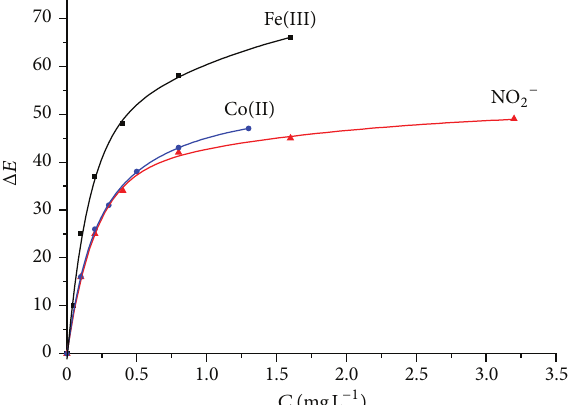
Figure 2: Concentration dependence of the total color difference ( Δ𝐸 ) calculated from the scanned images of the color scales on PUF tablets for the colored components: Co(II), Fe(III), and NO 2−